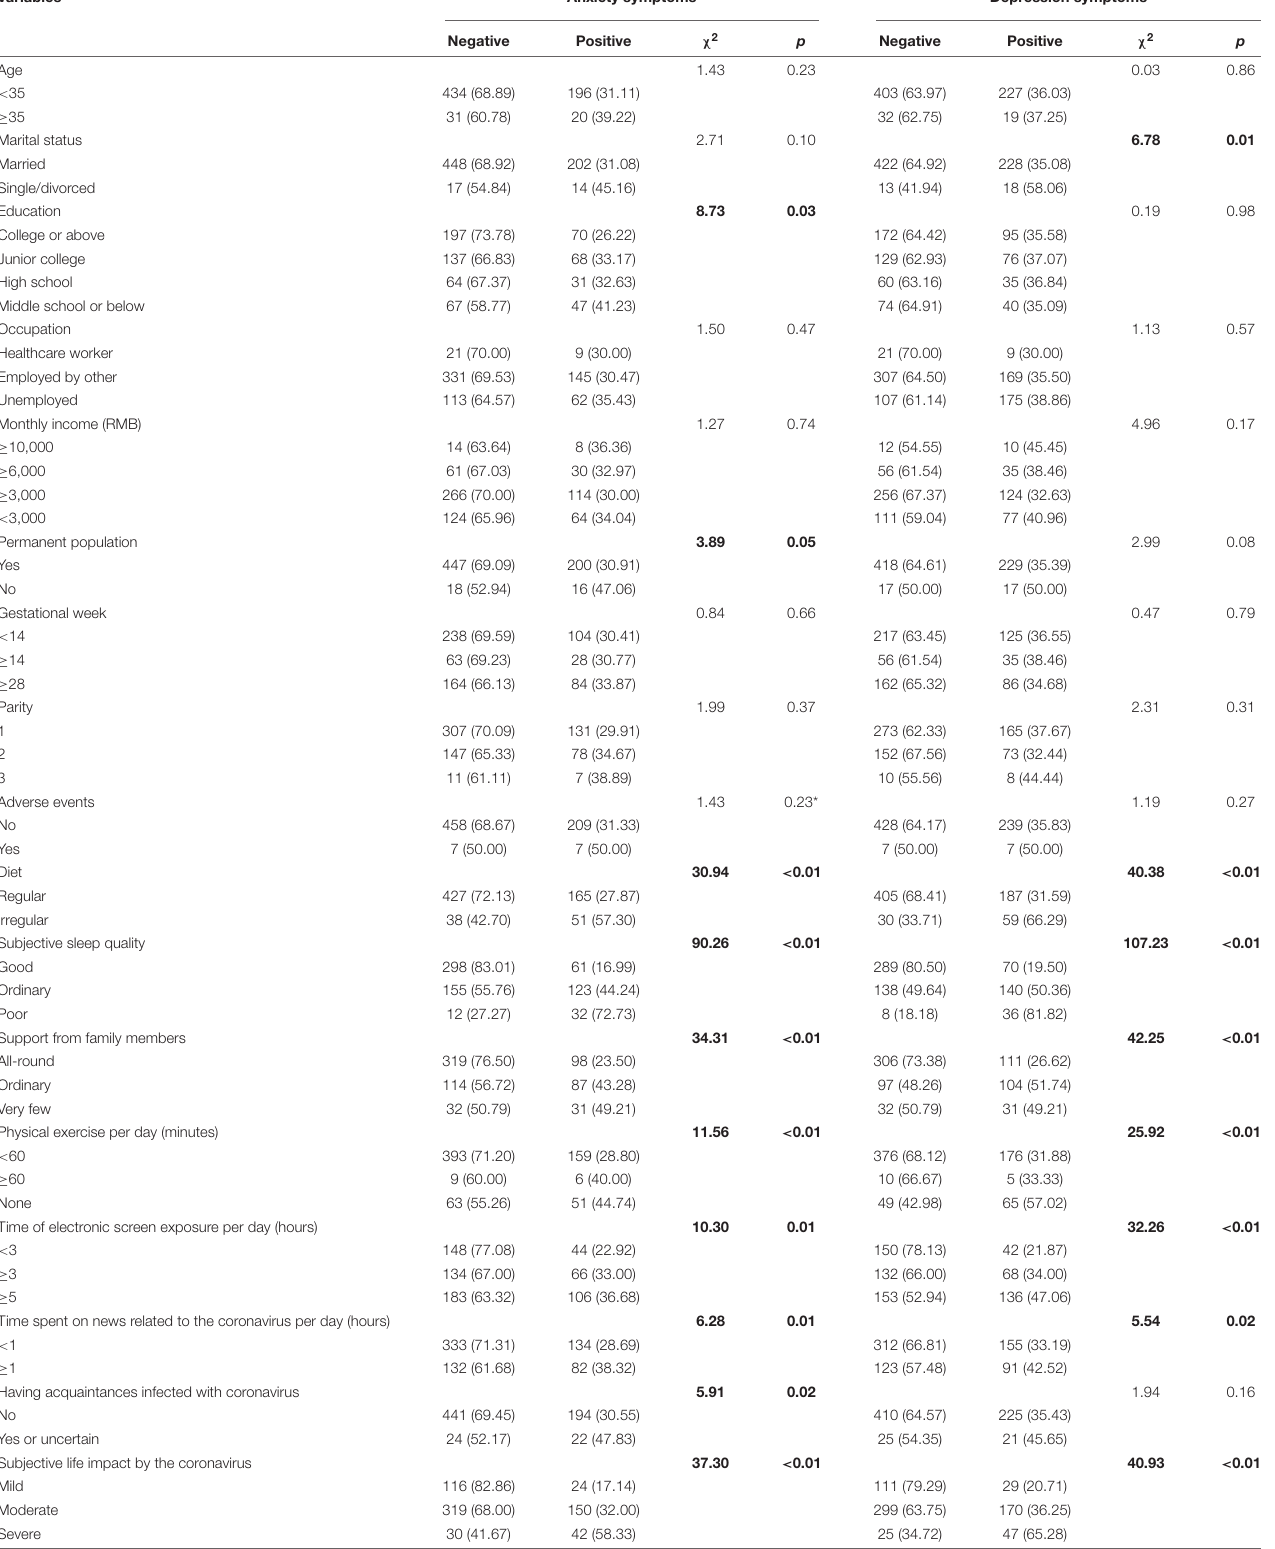
TABLE 1 | Distribution of factors between positive and negative groups and results of the chi-square test.